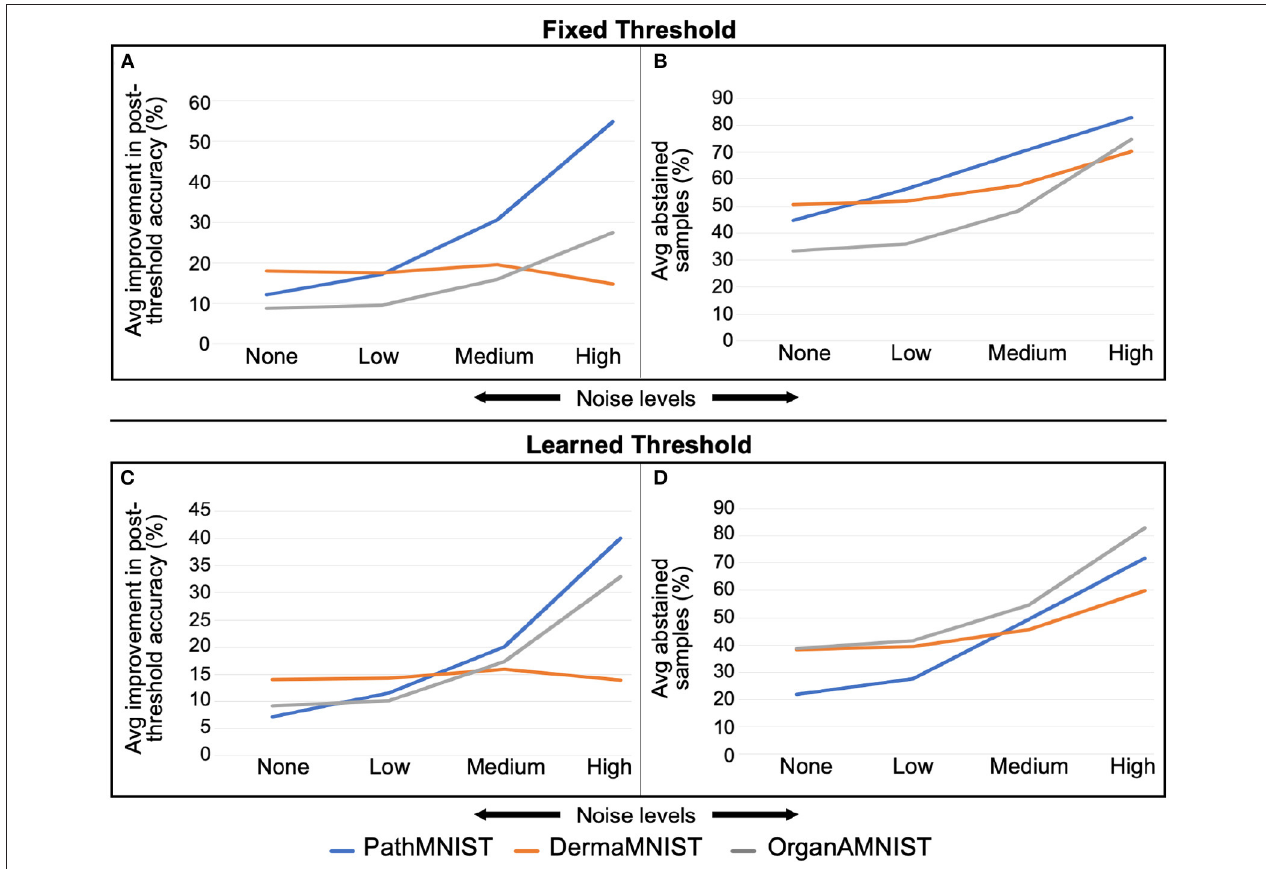
FIGURE 7 | (A,B) are for fixed threshold. (C,D) are for learned threshold. Increase in average improvement in post-threshold accuracy and average percent abstained samples with rising Gaussian noise levels is visible. This trend varies depending on the